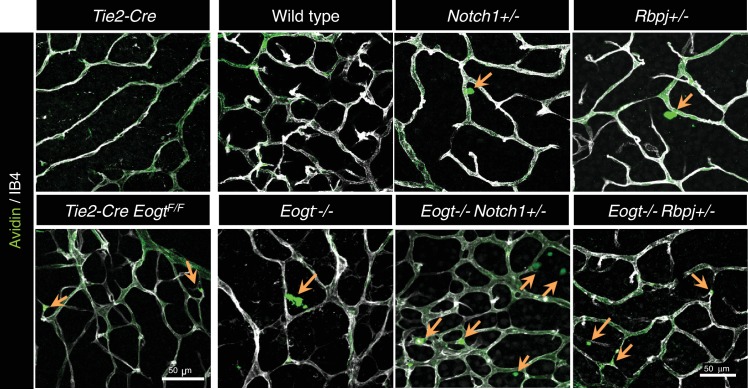
Sulfo-NHS-LC-biotin was perfused into P15 wild-type, Eogt−/−, Tek-Cre, Tek-Cre;EogtF/F, Notch1+/−, Rbpj+/−, Eogt−/−Notch1+/−, Eogt−/−Rbpj+/− mice and stained with CF488A-conjugated streptavidin (green) and Dylight594-conjugated IB4 (white) immediately after perfusion.The extravasation sites are shown by arrows.